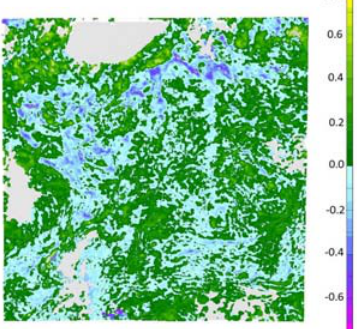
Figure 3 – Error map: DM, Template 25, Area01